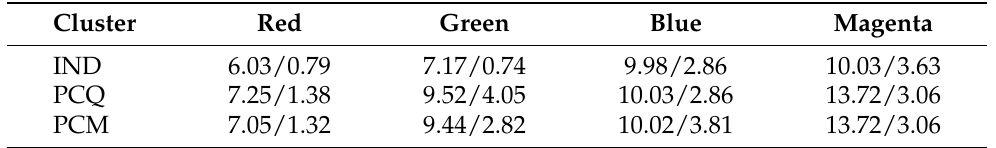
Table 3. Average speed values (m/s) over standard deviation (average speed/standard deviation) for time period t = 6 in the case of the IND, PCQ and PCM frameworks. Cluster Red Green Blue Magenta IND 6.03/0.79 7.17/0.74 PCQ PCM